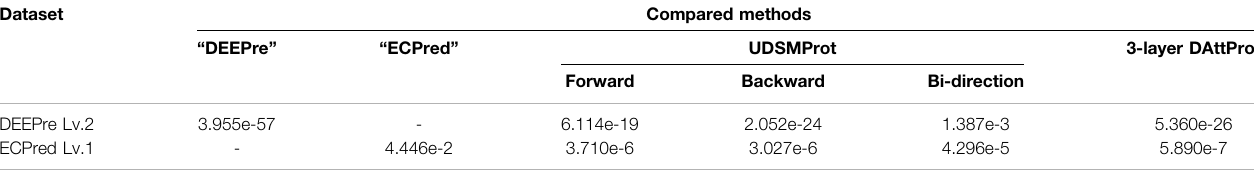
TABLE 6 | p-values of the unpaired and one-tailed heteroscedastic Student ’ s t-test on 6-layer DAttProt over compared methods on the last task level of each dataset. Dataset